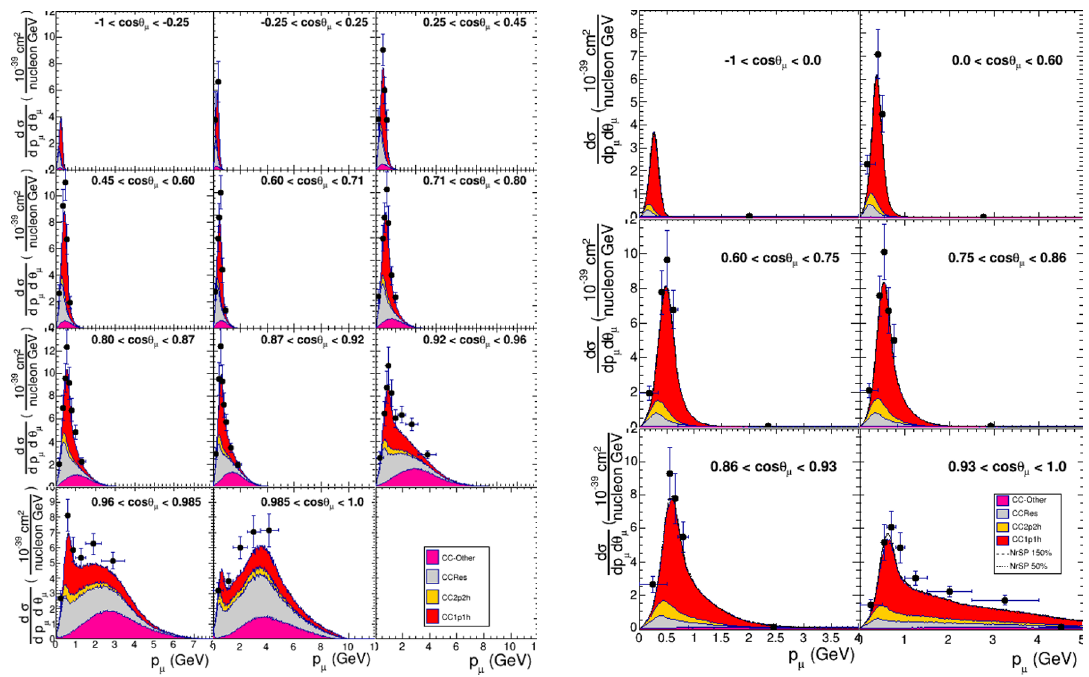
Figure 5 . T2K CC (left) and CC0 π (right) inclusive double differential cross-section dσ/dp µ d cos θ µ . Data, taken from refs. [12] and [13], respectively, are compared to the